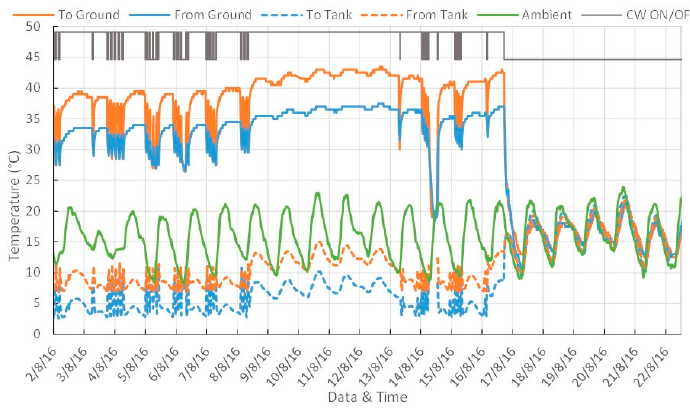
Figure 5. Temperatures of the condenser water loop (CW) ground loop, CW tank loop and the ambient air between August 1 and August 22, 2016.